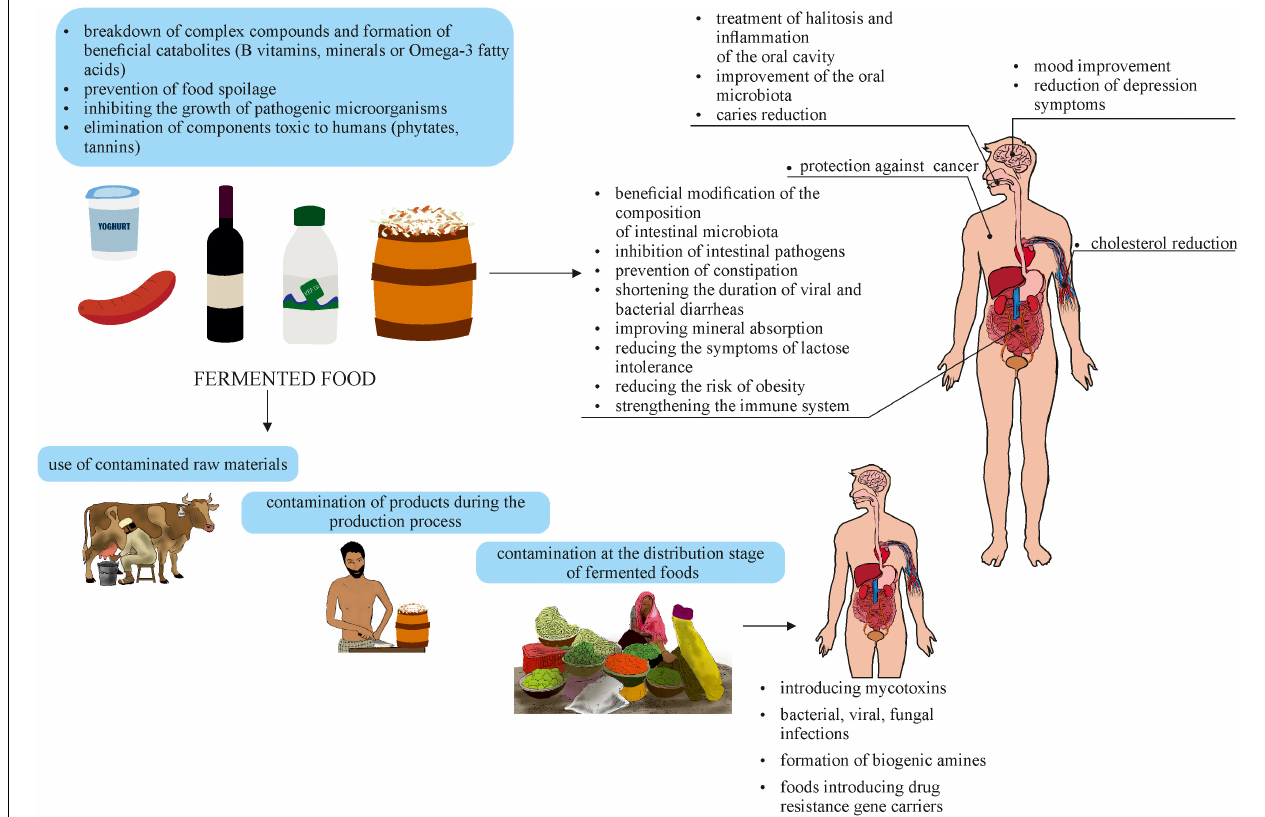
FIGURE 1 | Effects of consuming fermented